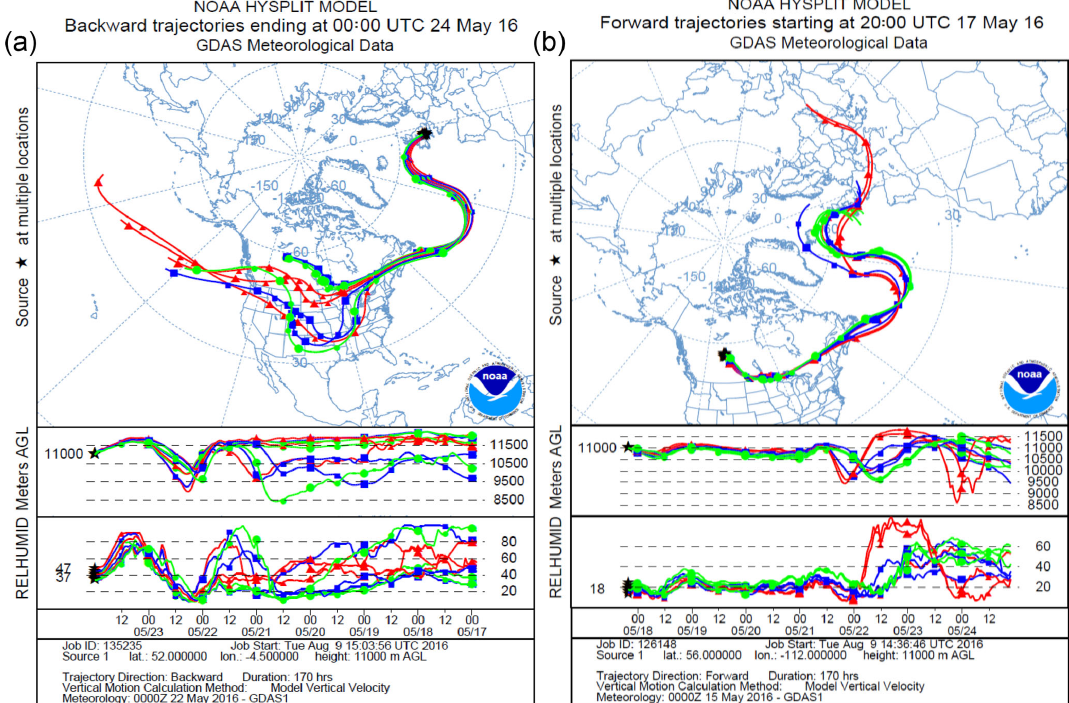
Figure 12. Back trajectories calculated by HYSPLIT. (a) Nine back trajectories started at 11km from a square 1 ◦ wide over Capel Dewi at 00:00UTC 24 May 2016; (b) Nine forward-trajectories started at 11km from a square 1 ◦ wide over 56.5 ◦ N, 111.5 ◦ W at 20:00UTC 17 May